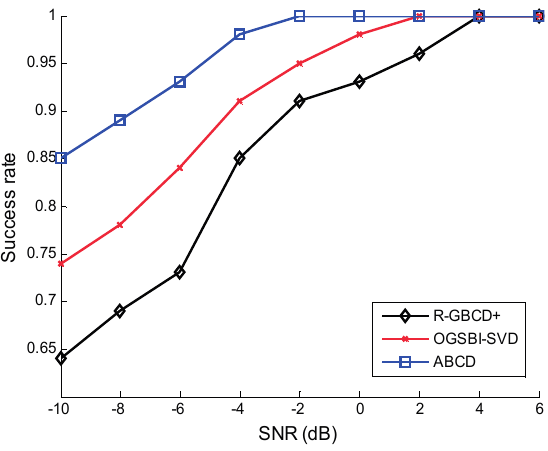
Figure 2. Success rates vs. SNR with the fixed number of snapshots